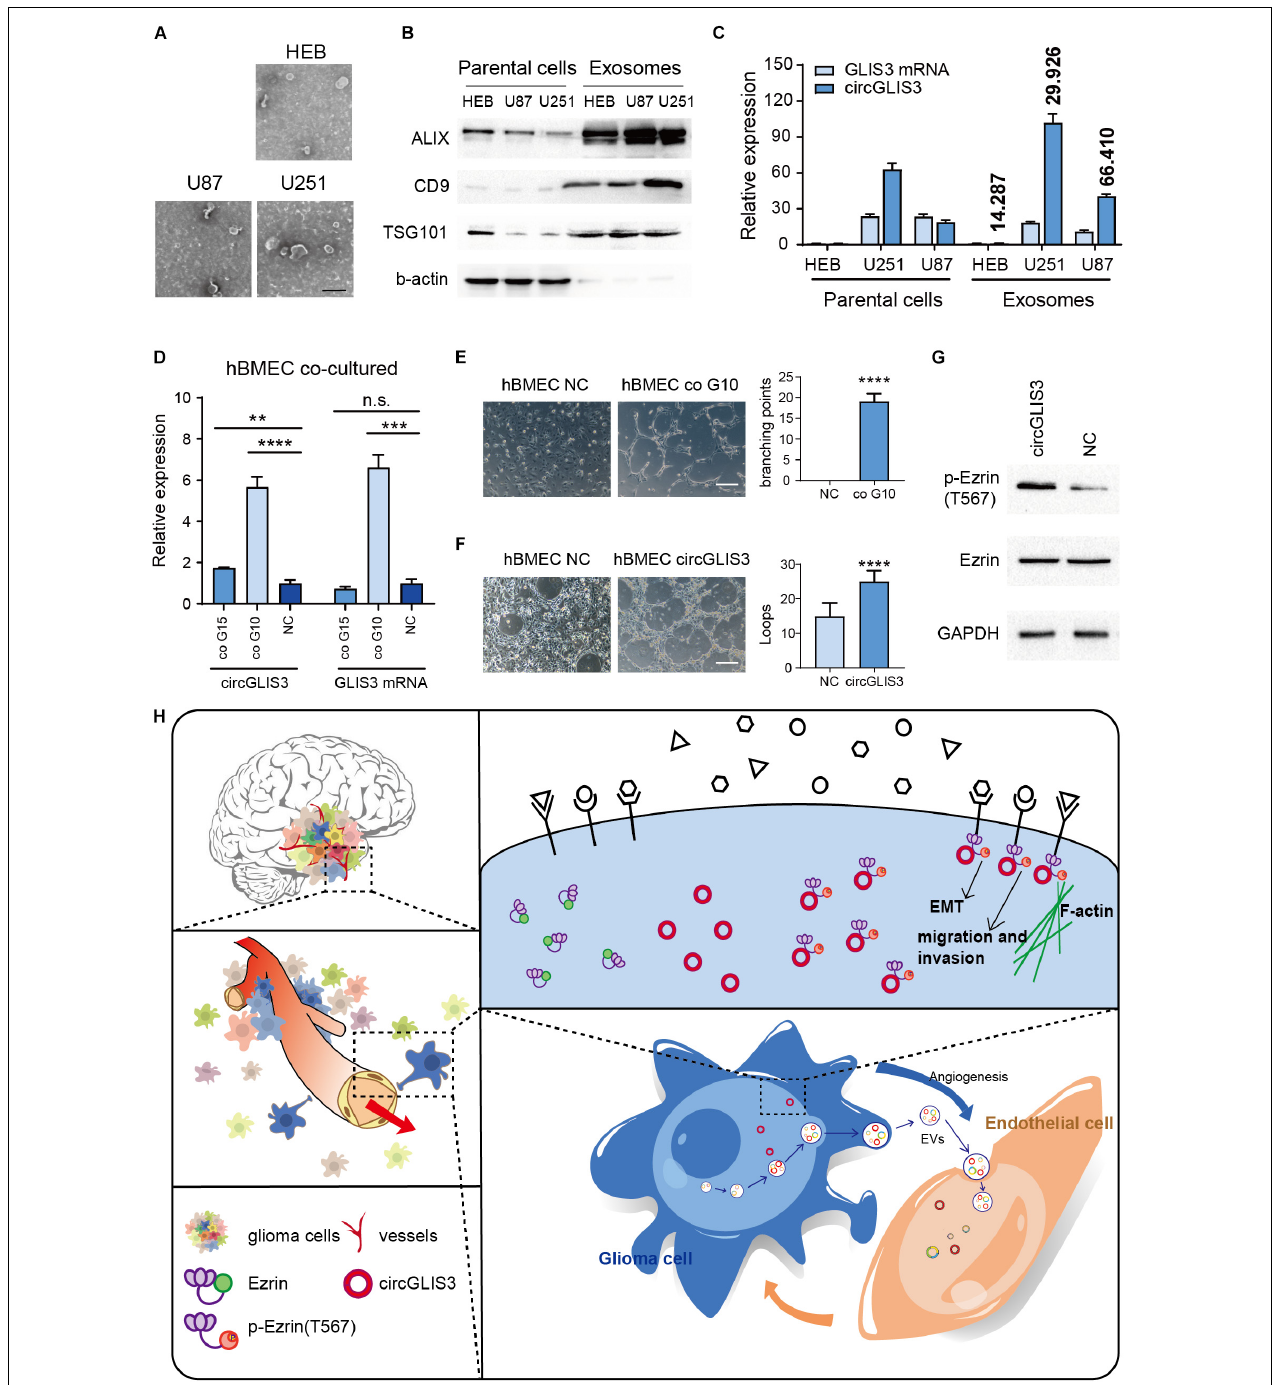
FIGURE 5 | CircGLIS3 is secreted into the microenvironment and participates in tumor angiogenesis. (A) Electron microscopy images of exosomes isolated from HEB, U87, and U251 cell culture supernatant (scale bar, 200 nm). (B) Western blot of exosomal markers and b-actin control in HEB, U87, and U251 cells and exosomes. (C) RT-PCR for the level of circGLIS3 and its linear counterparts in HEB, U87, and U251 cells (left) and corresponding exosomes (right); data were normalized to GAPDH. Fold enrichment of circGLIS3 compared to GLIS3 mRNA in each cell line is calculated according to 2 − (cid:49)(cid:49) CT and shown above the column. (D) RT-PCR of hBMEC after being cocultured with G15 and G10 for 5 days. Cells were cultured by a 1:1 mixture of primary glioma cell culture medium and ECM medium. (E) Tube formation assay of 3 × 10 5 hBMEC in a 24-well plate after being cocultured with G10 for 7 days (upper) or (F) after being transfected with circGLIS3 plasmid (300 ng/ml) for 48 h (lower) (scale bar, 150 µ m). (G) Western blot of p-Ezrin(567) and Ezrin in hBMEC after transfected with the circGLIS3 plasmid for 48 h. (H) Diagram of circGLIS3 in glioma progression. The results are presented as the mean ± SEM of biological triplicate assays. ** P < 0.01, *** P < 0.001, **** P <